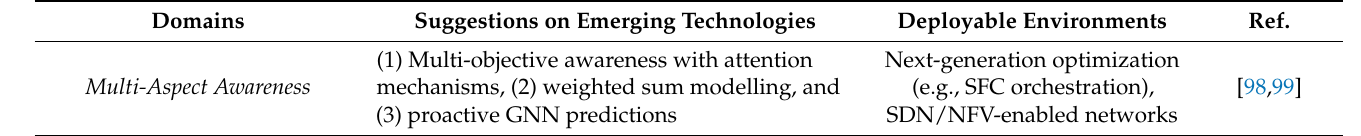
Table 8. Summary of Selected Challenges and Future Directions in Section 6.